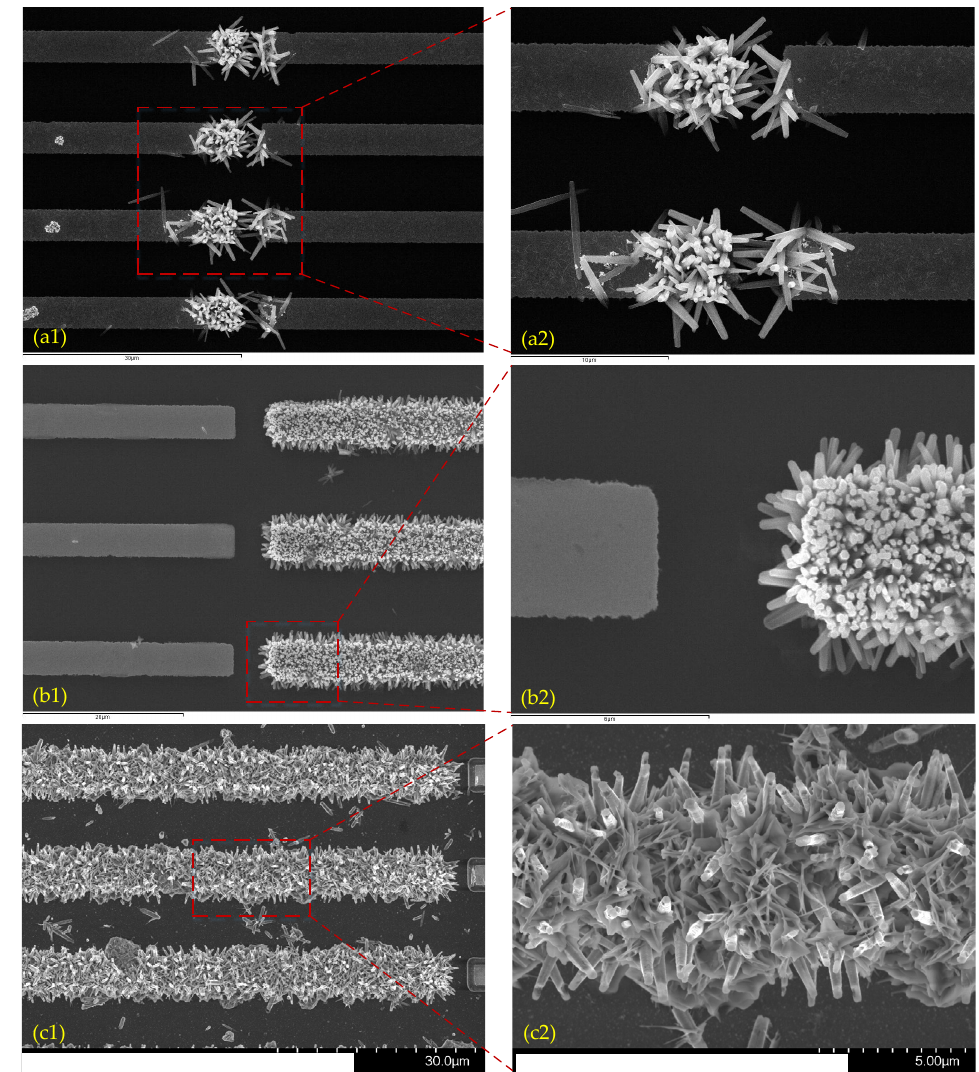
Figure 11. SEM images of ZnO nanowires grown on microelectrodes. ( a1 , a2 ) Only AC electric field is applied. ( b1 , b2 ) Only DC electric field is applied. ( c1 , c2 ) Both AC and DC electric fields are